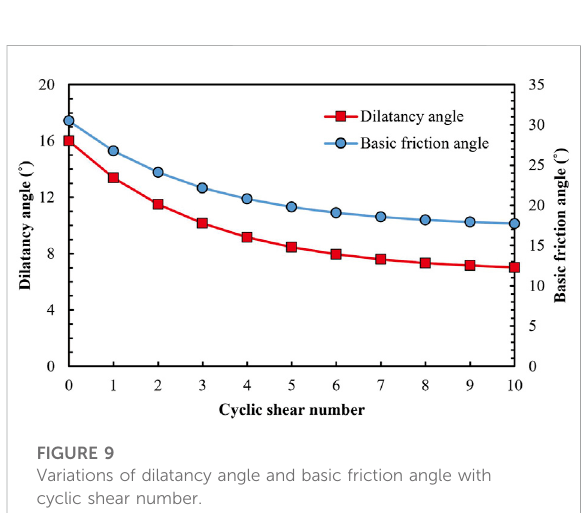
FIGURE 9 Variations of dilatancy angle and basic friction angle with cyclic shear number.